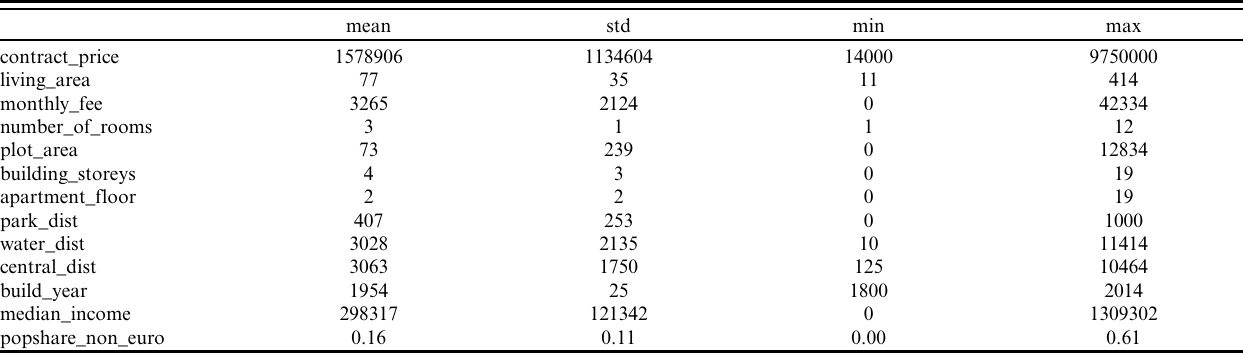
Table 1 . Summary statistics for final